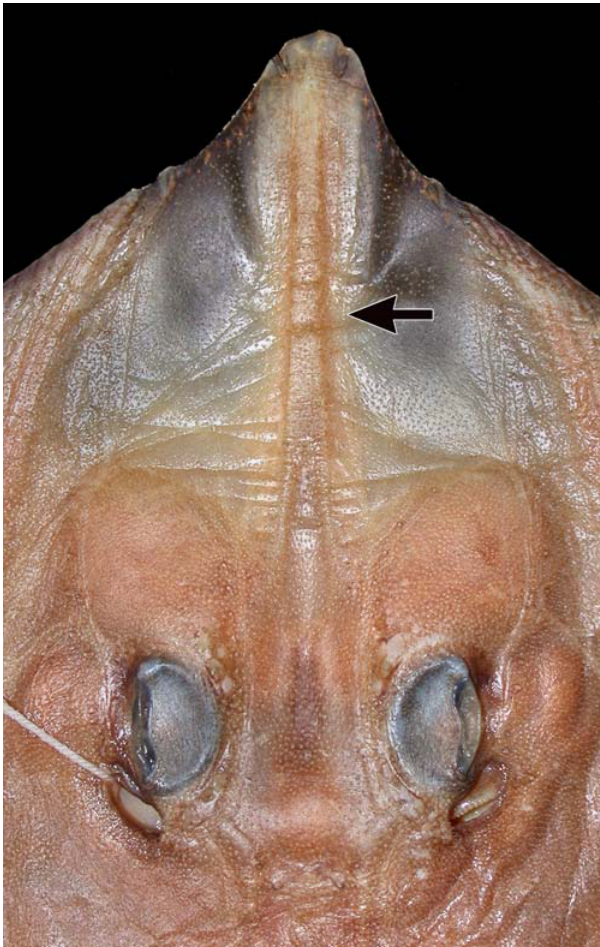
Fig. 4. Dorsal head region of Malacoraja obscura , n. sp. (MNRJ 28291, 355 mm TL). Arrow indicates posterior extent of rostral appendices on